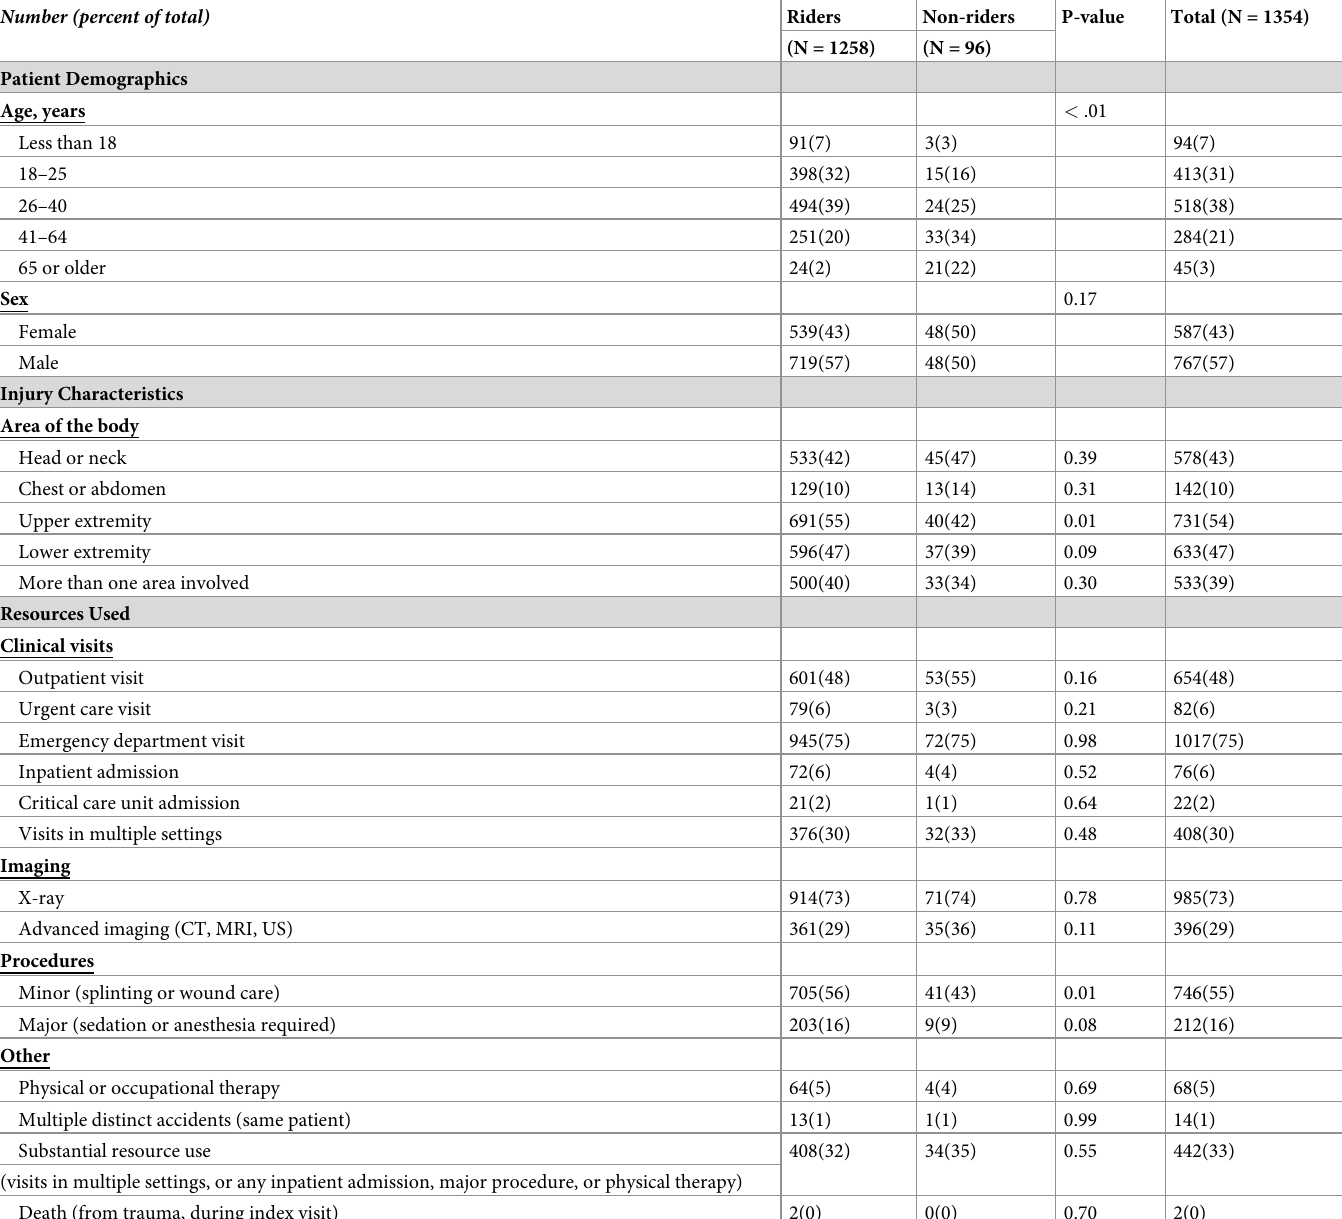
Table 1. Characteristics of patients with confirmed e-scooter injuries �